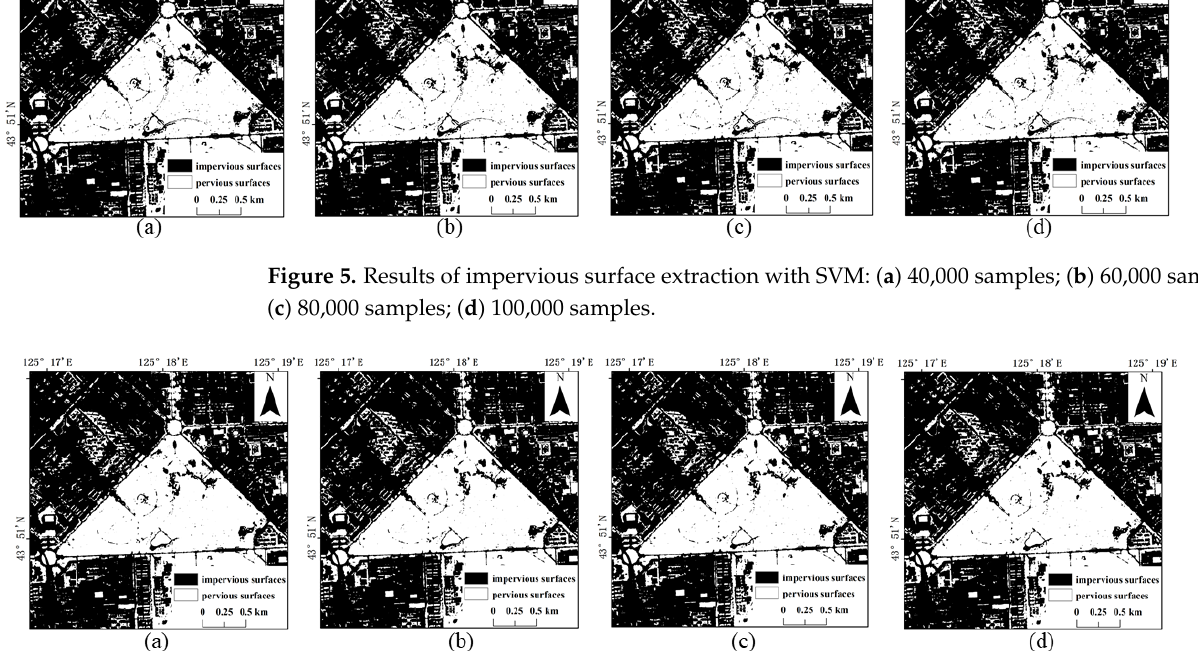
Figure 7. Results of impervious surface extraction with BDA: ( a ) 40,000 samples; ( b ) 60,000 samples; ( c ) 80,000 samples; ( d ) 100,000 samples. Figure 8. Results of impervious surface extraction with GBDA: ( a ) 40,000 samples; ( b ) 60,000 sam- ples; ( c ) 80,000 samples; ( d ) 100,000 samples. Among the four methods, SVM obtained the lowest accuracy and the two methods, BDA and RF, had similar extraction accuracy with higher accuracy values than SVM. Compared to SVM, the maximum increase in OA of BDA was 3.77%, the maximum in- crease in Kappa value was 0.0752 and the maximum increase in 𝐹 (cid:2869) value was 0.0276. The OA and Kappa of GBDA with a prior optimization were substantially improved com- pared with the other three methods. Compared to BDA, GBDA had a maximum increase of 3.23% in OA, 0.0647 in Kappa and 0.0352 in 𝐹 (cid:2869) value.